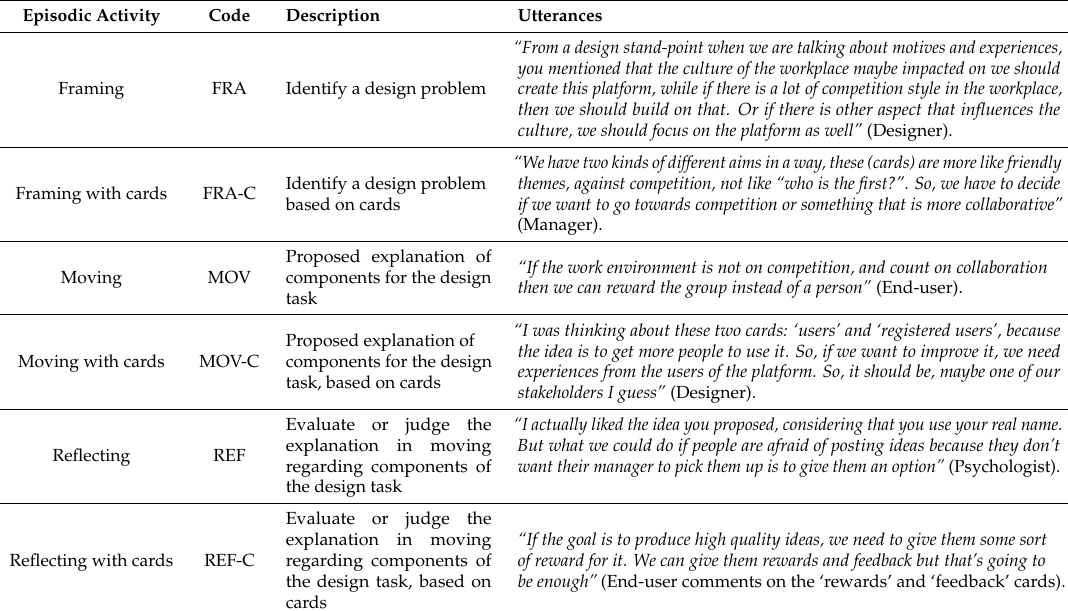
Table A1. Examples of “framing-moving-reflecting” activities during the